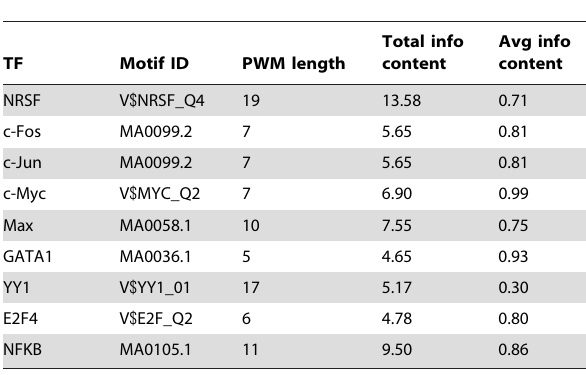
Table 2. Motifs used in benchmark.